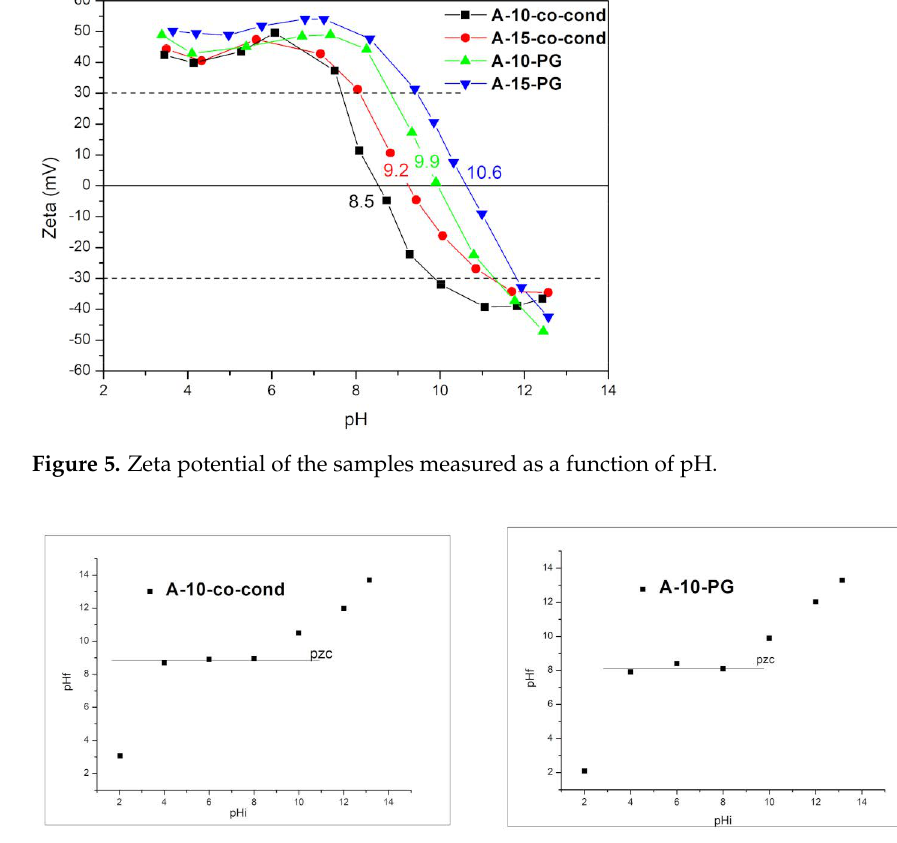
Figure 6. Point of zero charge, pZc of the A-10-co-cond ( left ) and A-10-PG ( right )